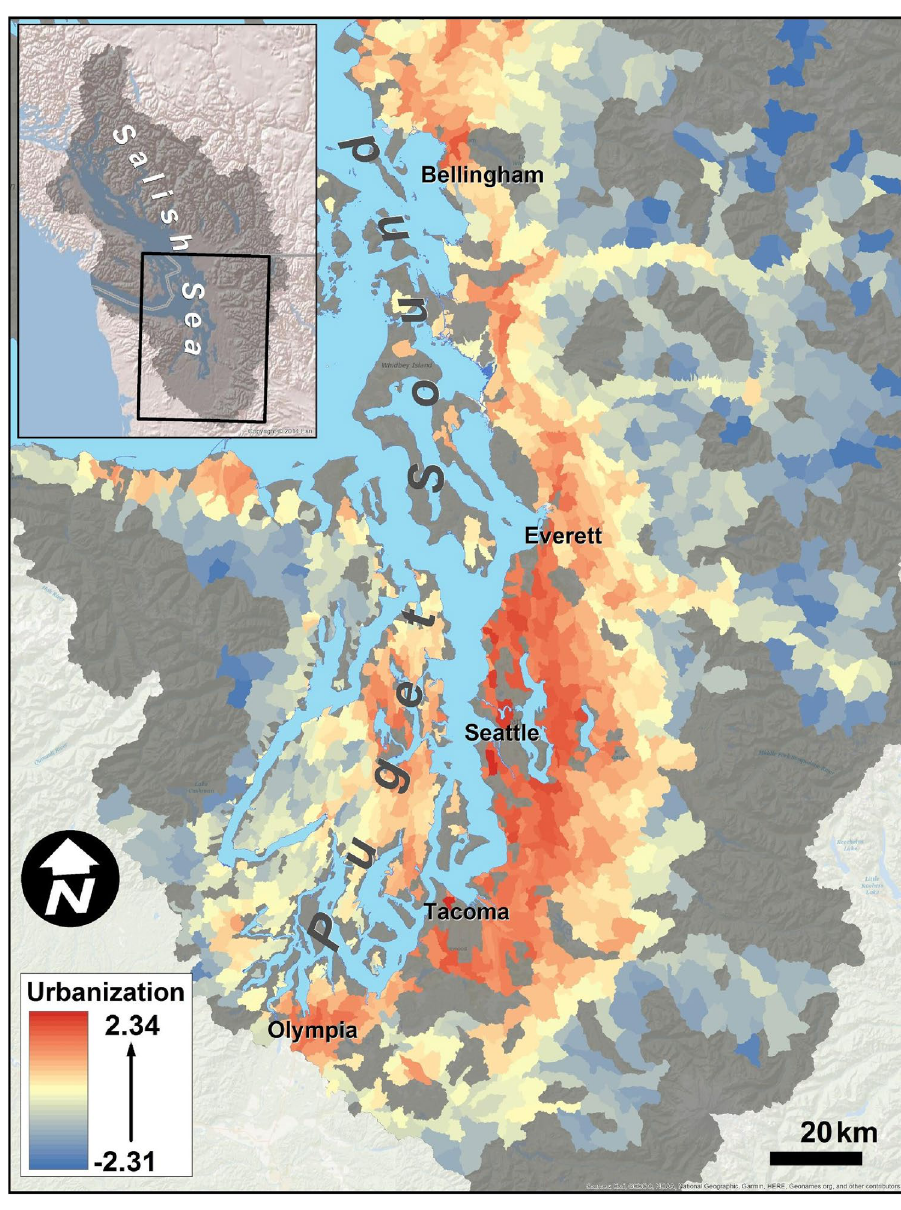
Figure 2. Gradients of urbanization across watersheds in the Puget Sound Basin. Urbanization represents the combined effects of 19 land cover (e.g., higher imperviousness) and land use (e.g., increasing motor vehicle traffic) attributes on coho pre-spawn mortality risk, estimated using a Bayesian structural equation model 42